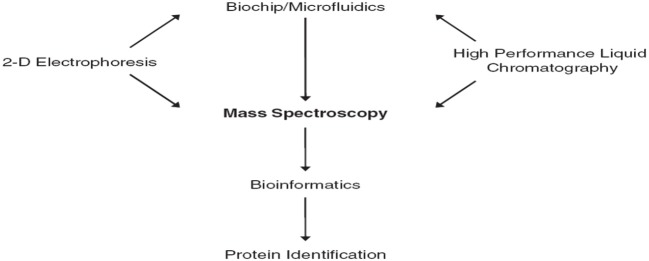
The central role of mass spectrometry in proteomics (Jain, 2010).